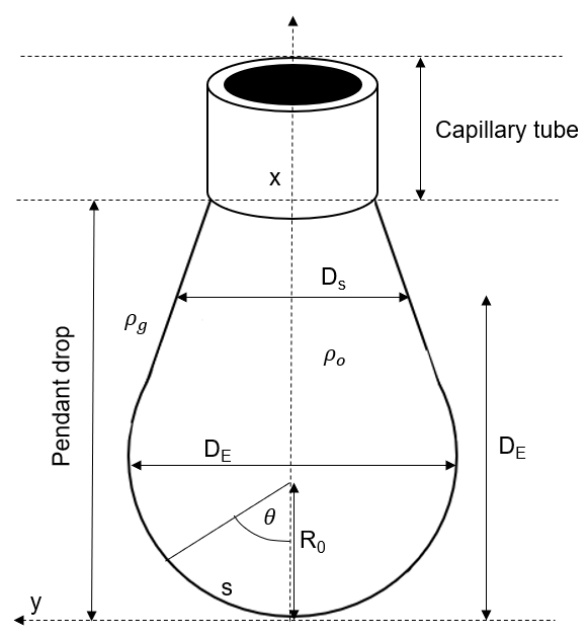
Figure 4. Variables to estimate the IFT with an oil-drop image. 182